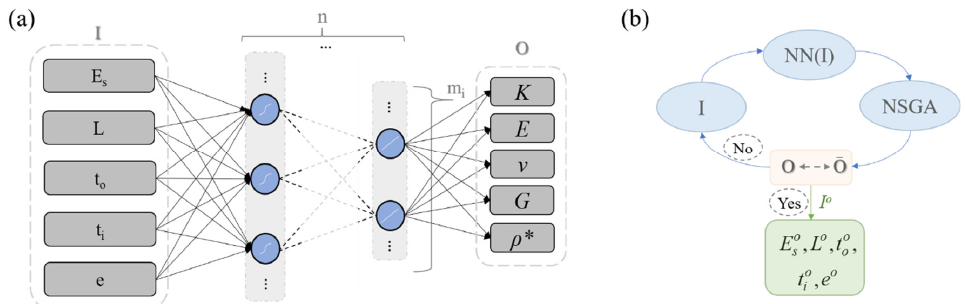
Figure 4. Machine learning modeling architecture for the prediction of the effective normal, bulk, shear, Poisson and relative density properties based on first- and second-scale inner design parameters ( a ). The model size defined by the number of layers n and neurons per layer m, as well as the activation function employed, constitute supervised learning parameters to be determined. The trained NN model is coupled to a Non-dominated Sorting Genetic Algorithm (NSGA) for the identification of optimal design parameter sets ( b ).